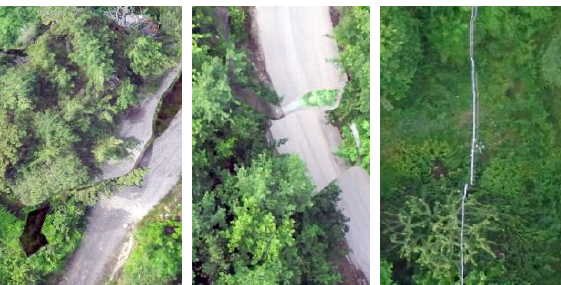
Figure 11. Example of mosaicking issues in areas with dense/high